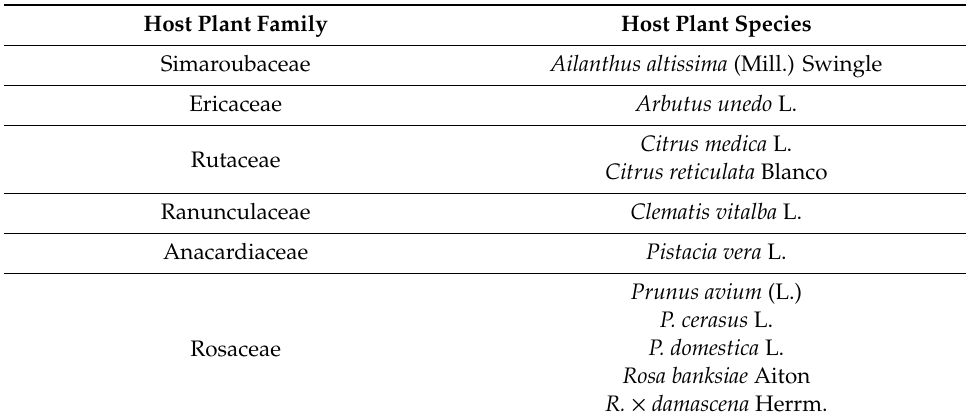
Table 3. Additional host-plant species found infested by A. spiniferus in the present study. Host Plant Family Host Plant